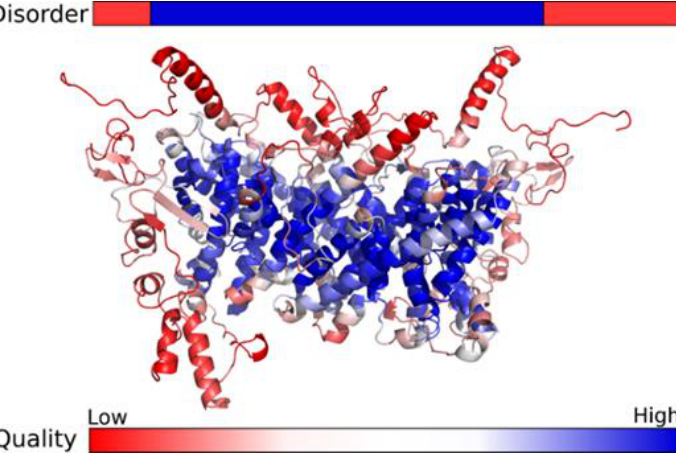
Figure 2. Disorder predictions and structure model of SLC9A6 dimer. Low quality regions in the structural model (red) usually correspond to parts of the protein predicted to be disordered, and the structured core of the dimer is predicted with higher confidence (blue).